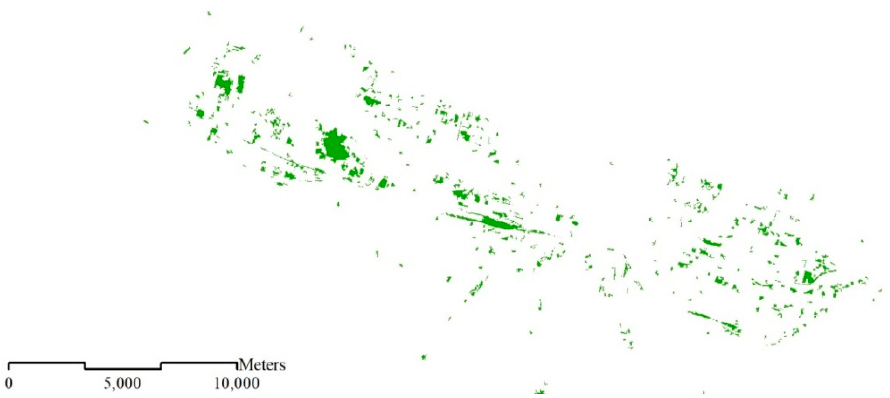
Figure 12. Obtained free spaces within urban areas.